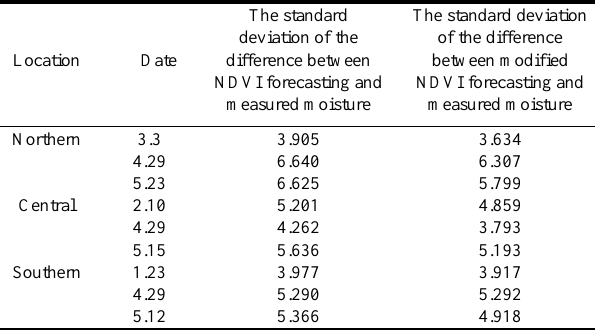
Table 10. Accuracy analysis of 10cm soil moisture